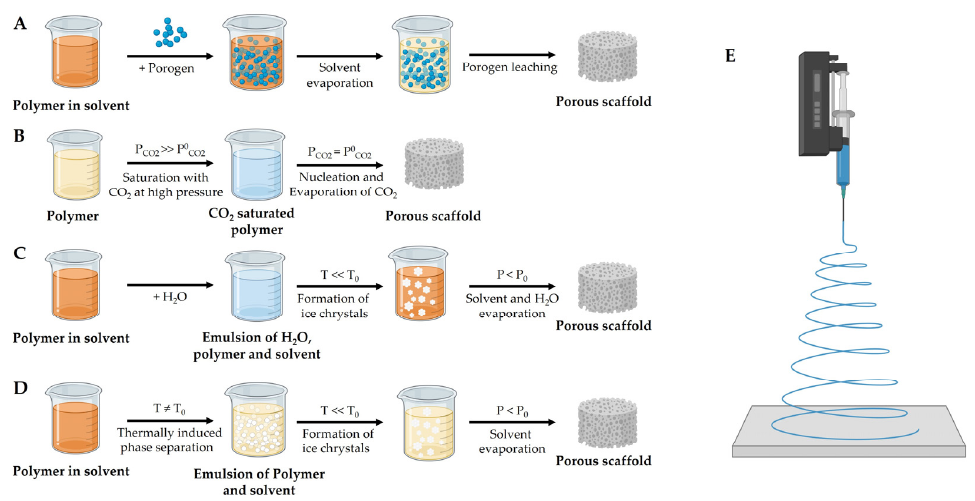
Figure 2. Different methods for the manufacture of porous scaffolds. ( A ) A polymer is brought into solution in its solvent form and mixed with porogen particles. After solvent evaporation, the porogen is leached out, leaving a porous structure behind. ( B ) For gas foaming, a polymer is saturated with an inert gas under high pressure. Releasing the pressure to ambient levels results in the nucleation of gas bubbles, followed by evaporation of the gas, resulting in a porous scaffold. ( C ) In freeze drying, an emulsion of a given polymer in its solvent and water is created. After the temperature is lowered, ice crystals are formed within the polymer, the subsequent application of a vacuum facilitates the solvent and water evaporation thereby creates porous structures within the scaffold. ( D ) in TIPS, a phase separation between the polymer and solvent is induced by changes in the thermal energy. Adjacent freeze drying facilitates solvent evaporation. ( E ) Electrospinning utilizes a high-voltage field to draw a polymer filament onto a collector plate. Figure is partly adapted from [96] . Figure contains illustrations and icons created with BioRender.com.